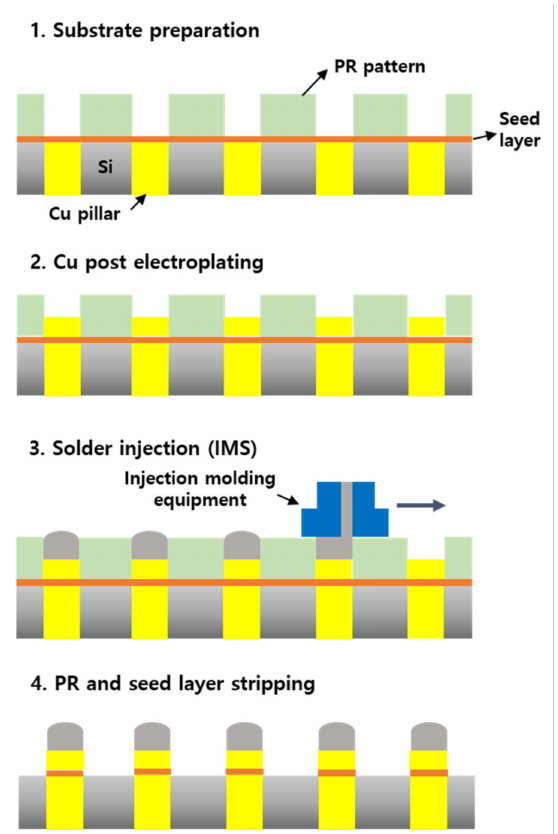
Figure 21. Solder bumping by injection molded solder